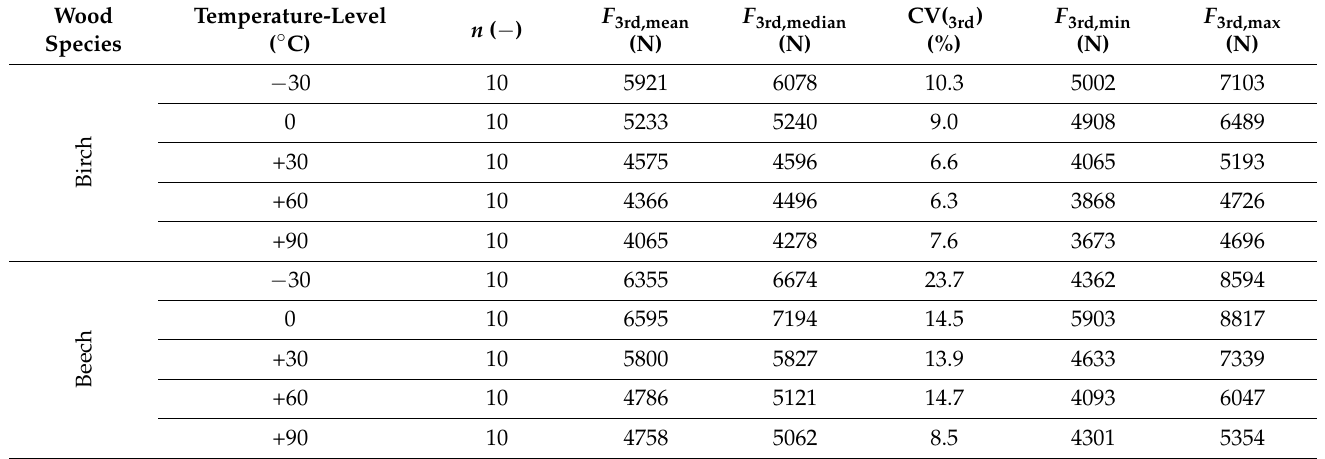
Table A3. Essential statistics regarding the maximum force level (3rd peak) of birch and beech: mean value of the 3rd peak ( F 3rd,mean ), median value of the 3rd peak ( F 3rd,median ), coefficient of variation of the 3rd peak (CV( 3rd )), minimum value of the 3rd peak ( F 3rd,min ) and maximum value of the 3rd peak ( F 3rd,max